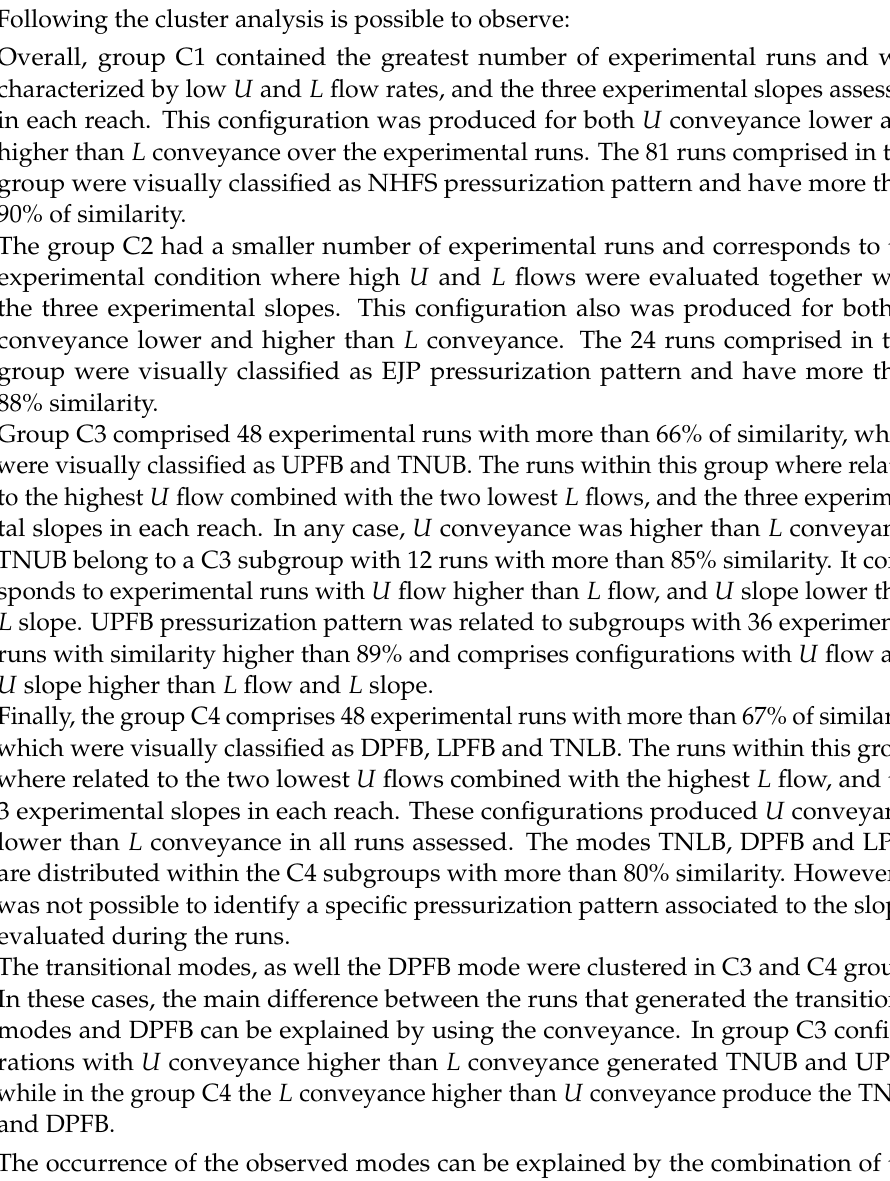
Figure 10. Dendrogram from the hierarchical clustering of 201 runs ( a ) and Scatter plots of the selected Q U variables ( b